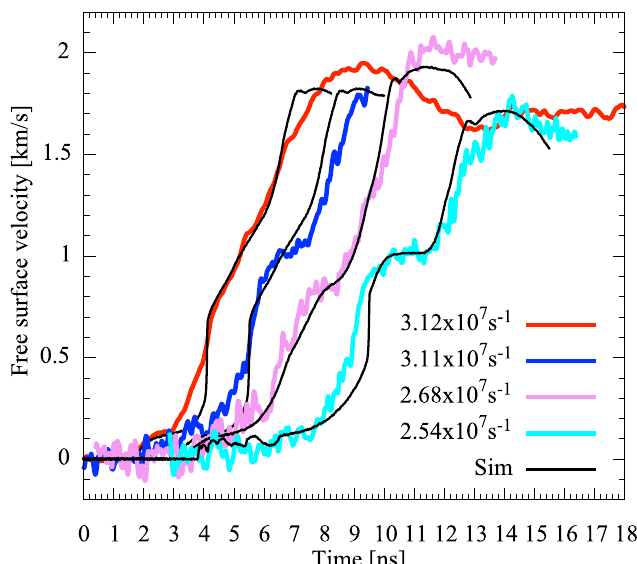
Figure 6. VISAR profiles for different loading rates for the iron 50 microns thick target. The black thin lines are numerical simulations where the completion time was set to be 4 ns for the loading rate of 3.12 and 3.11 × 10 7 s − 1 and 3.25 for those of 2.68 and 2.56 × 10 7 s − 1 . For clarity, the velocity profiles are temporally